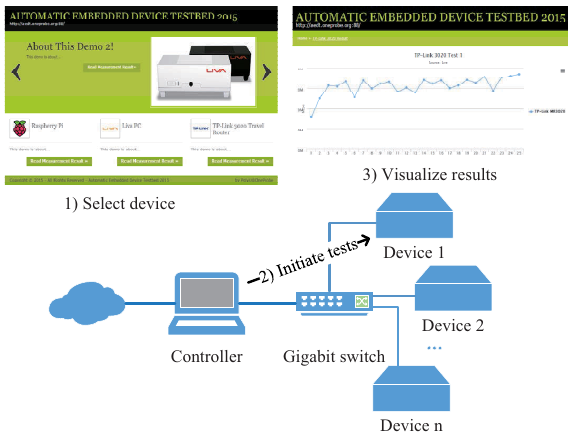
Figure 1: The testbed setup and test flow.